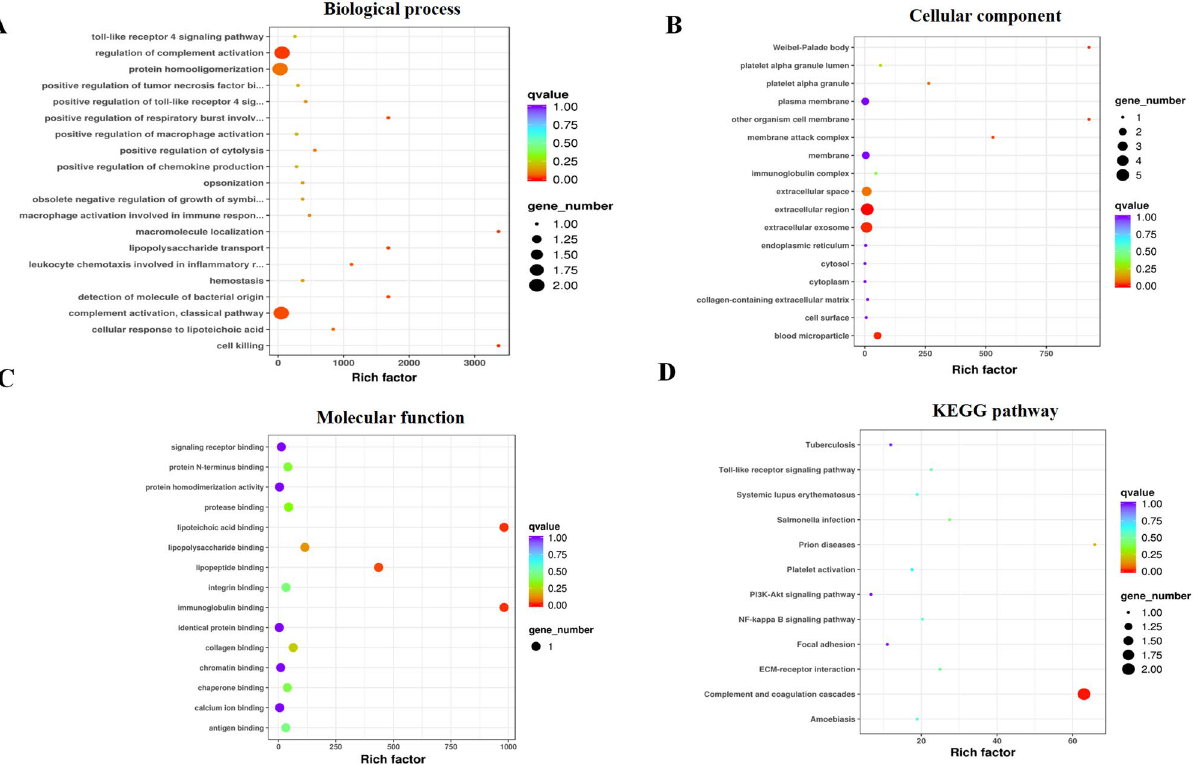
Figure 6. Gene Ontology (GO) and Kyoto Encyclopedia of Genes and Genomes (KEGG) enrichment analysis of differentially expressed proteins identified in serum EVs (sEVs). The Bubble plots were drawn by the R program. And the R program was written after enrichment significance, which was calculated by Fisher’s exact test. Bubble plots showing enrichment for the GO biological process ( A ), cellular component ( B ), and molecular function ( C ). A bubble plot showing enrichment for KEGG pathways ( D